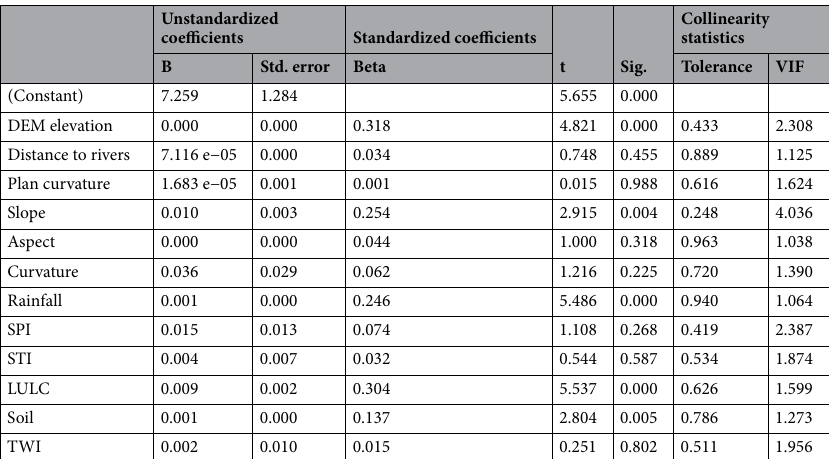
Table 4. Multicollinearity analysis of